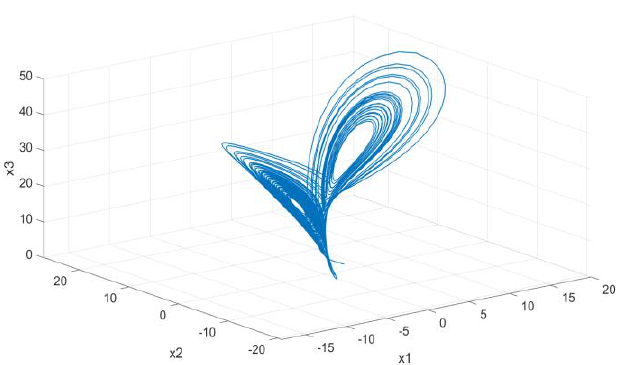
Figure 2. The bounded strange attractor of Lorenz system with the embedded message m ( t ) = 0.5sin ( 8 t ) .